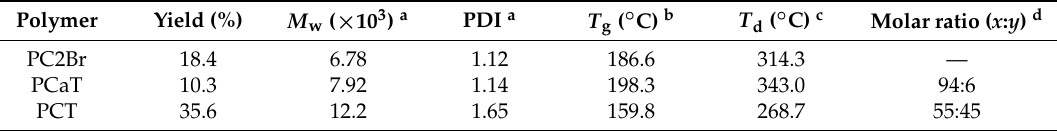
Table 1. Molecular weights and thermal properties of